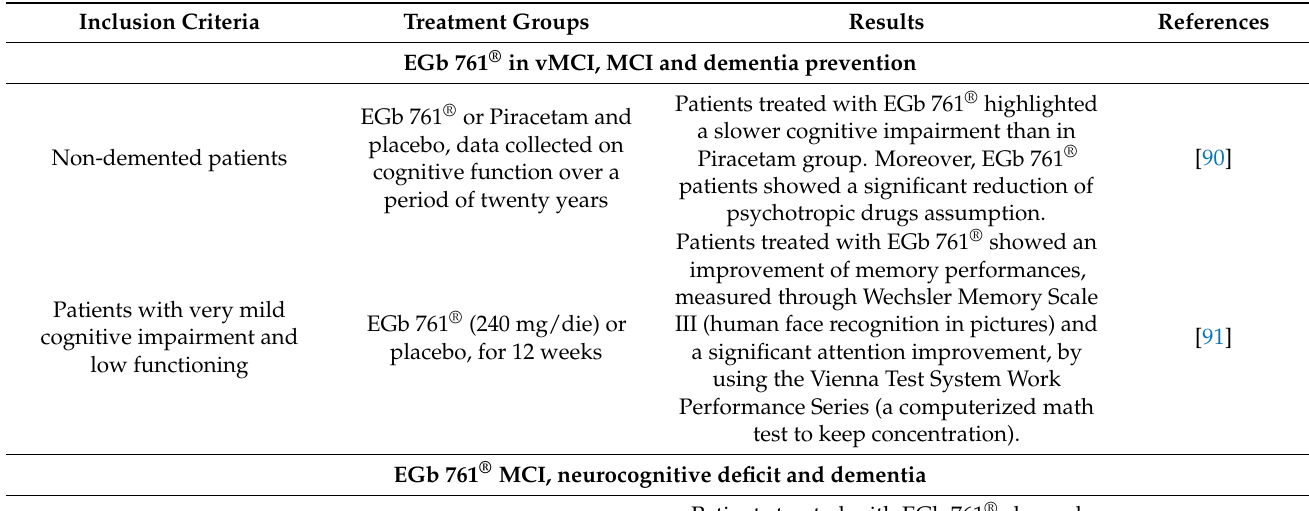
Table 2. Clinical studies on EGb 761 ® in patients with MCI, vMCI, and dementia.